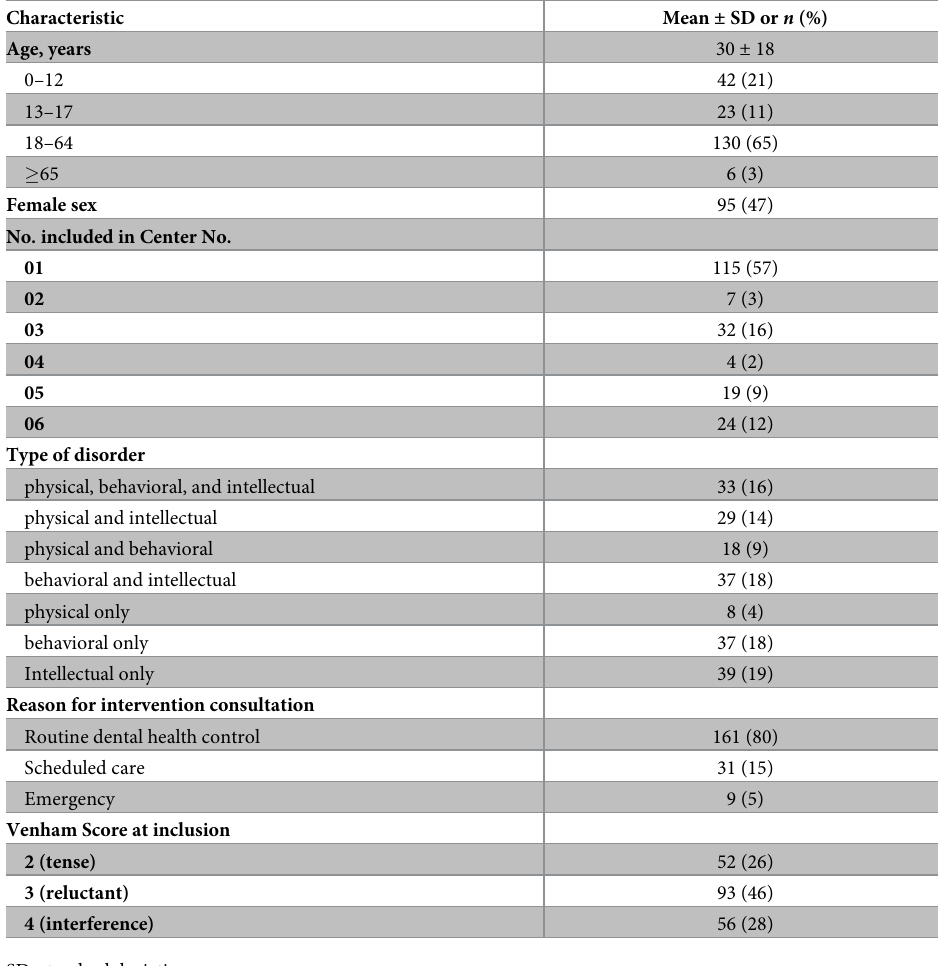
Table 1. Participant characteristics at inclusion (n =